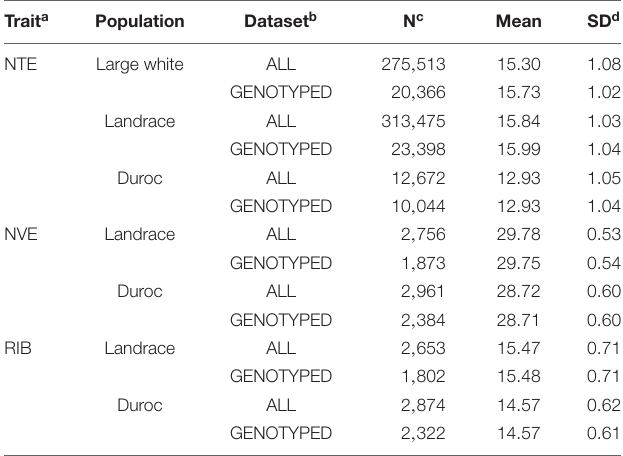
TABLE 1 | Summary